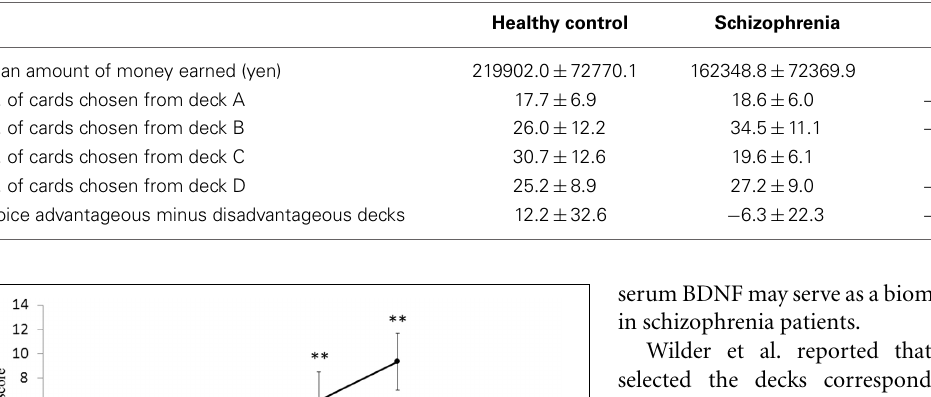
Table 2 | Iowa Gambling Task performance of the schizophrenia patients and the healthy control group.